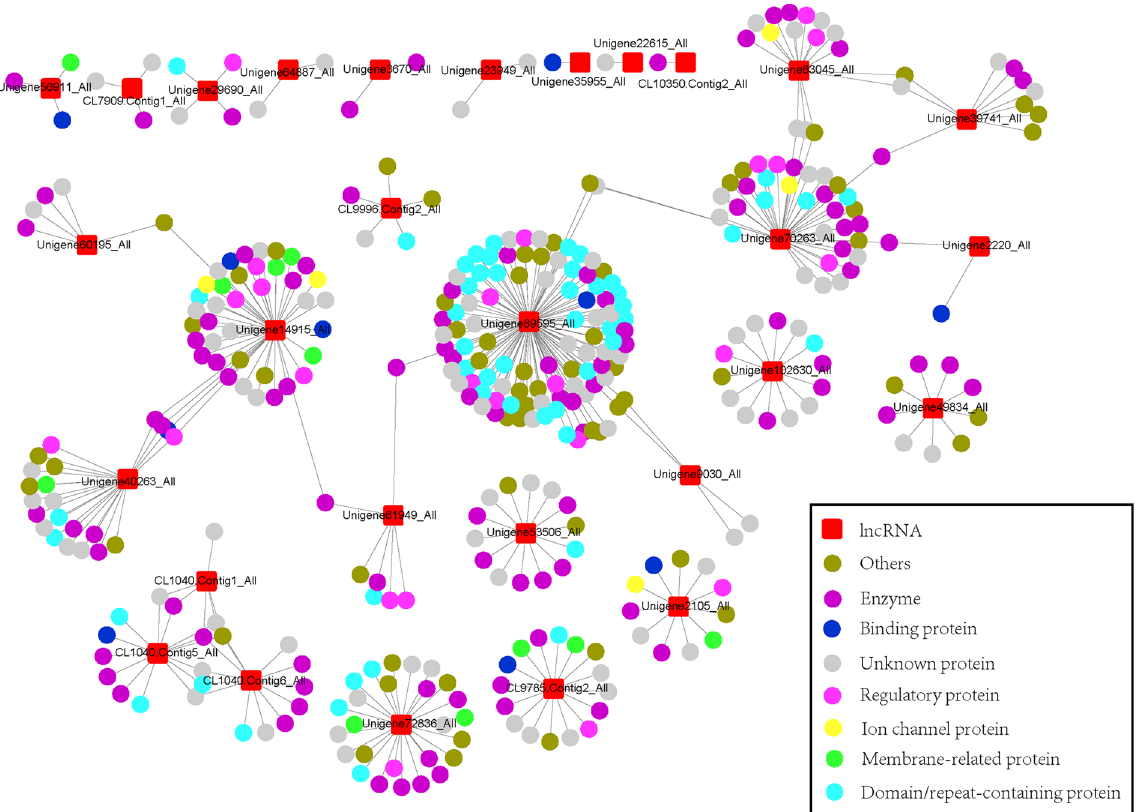
Figure 6. lncRNA-mRNA interaction network constructed based on the 29 lncRNA-mRNA interaction pairs. Target mRNAs were classified based on coding proteins annotated from BLAST alignment against the NR database. The lncRNA-mRNA interactions not only contain relatively perfect complementary base-pairing, but also require low interaction energy ( ≤− 20) for